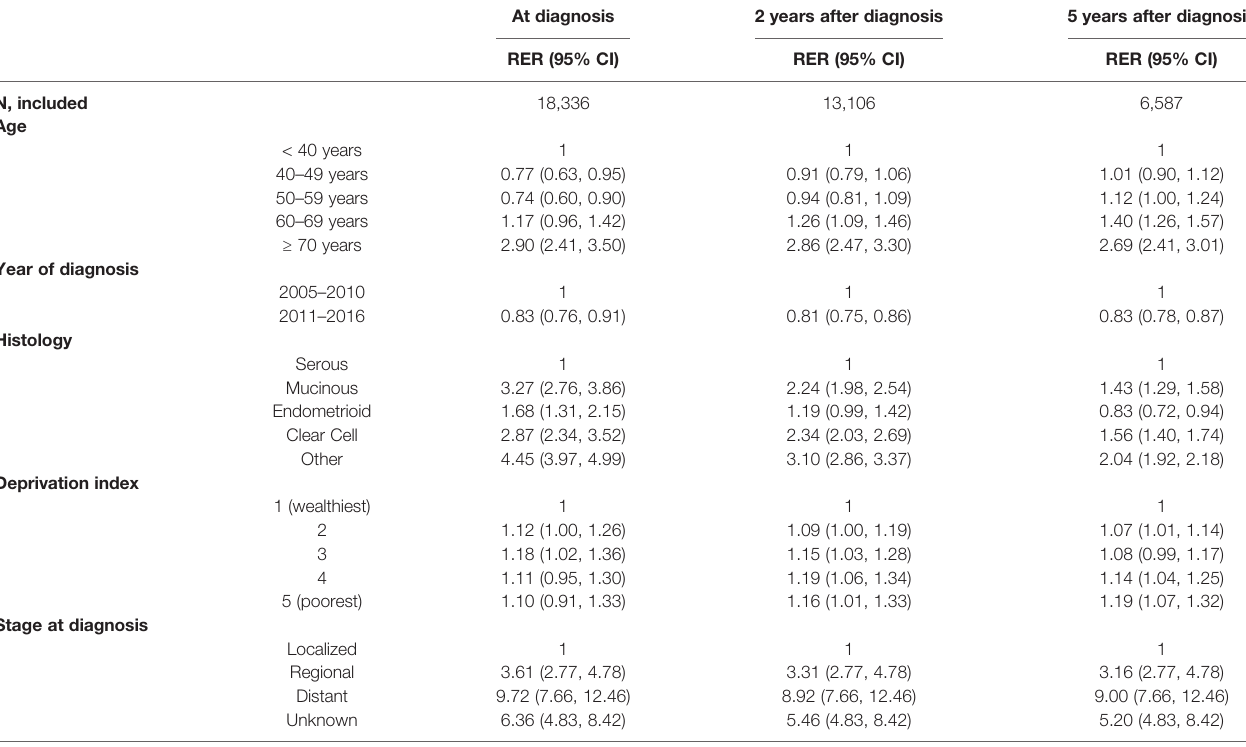
TABLE 4 | Factors associated with mortality according to survival time since diagnosis, 2005 – 2016: multivariate analyses (N=18,336). At diagnosis 2 years after diagnosis 5 years after diagnosis RER (95% CI) RER (95% CI) RER (95%